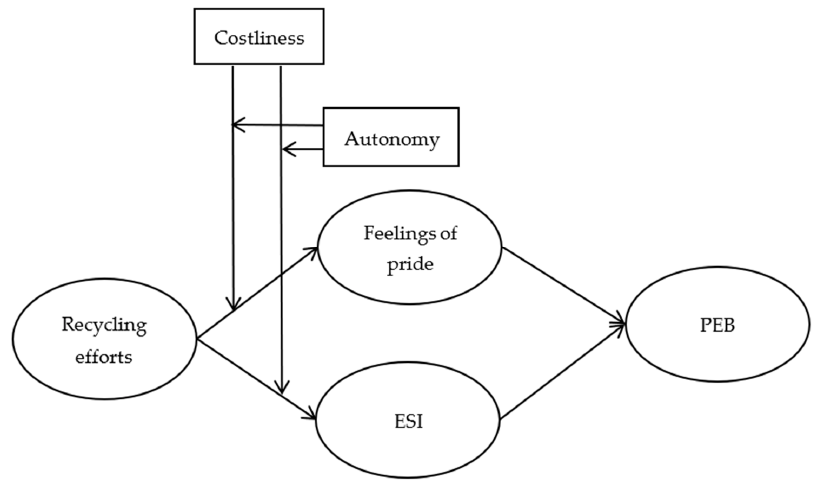
Figure 1. Conceptual